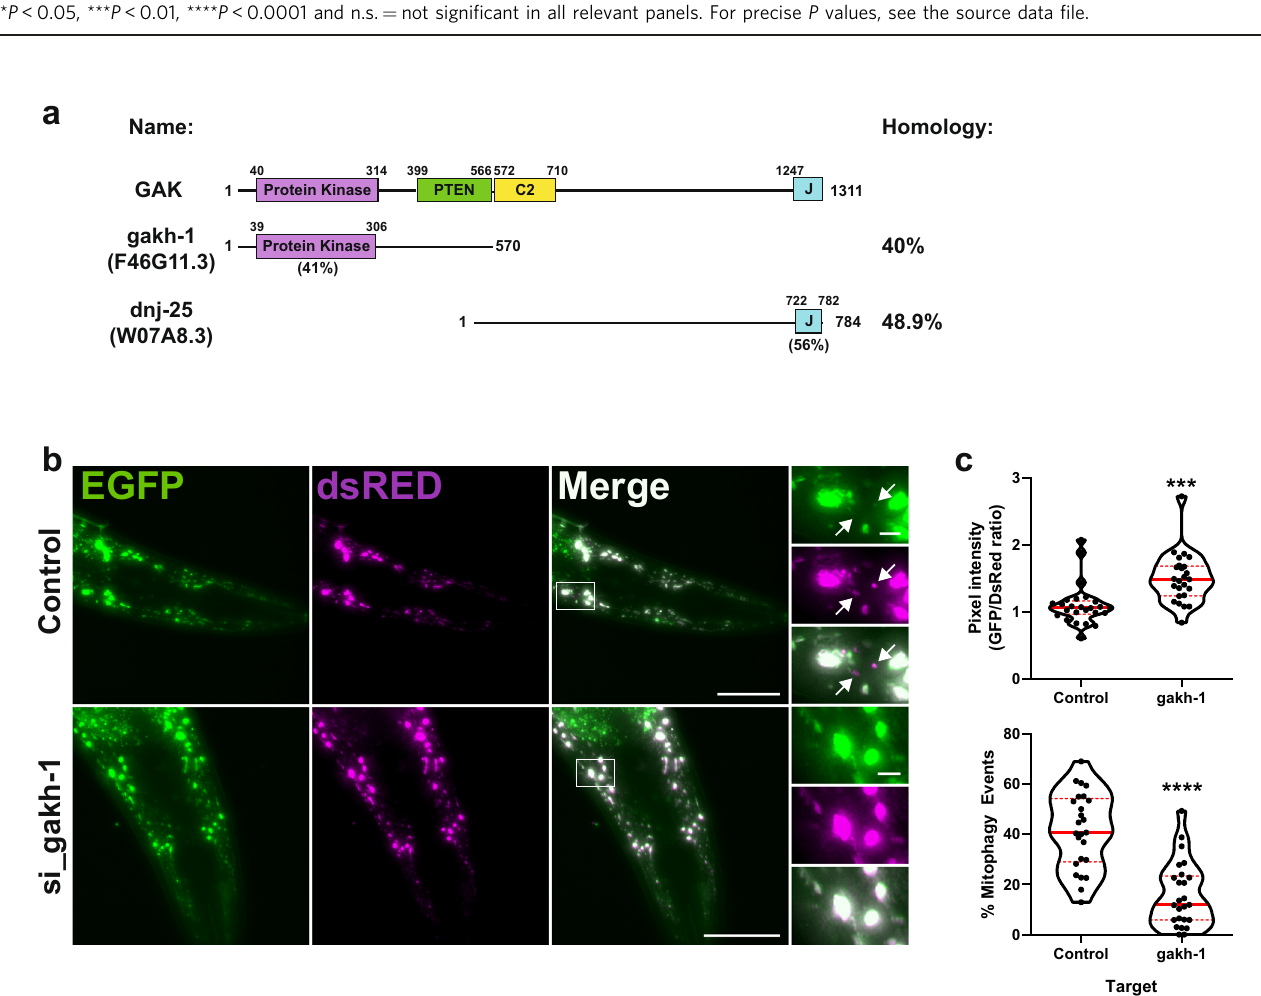
Fig. 7 GAKi induces abnormal mitochondrial and lysosomal morphology. a Representative ×63 images of U2OS IMLS cells taken by Zeiss LSM710 confocal microscopy. Cells were treated ± 1 mM DFP 24 h in addition to GAKi (10 µ M), sotrastaurin (PKCi — 2 µ M), oligomycin and antimycin A (O + A — 10 µ M and 1 µ M, respectively) or CCCP (20 µ M), scale bar = 10 µ m. b Machine-learning classi fi cation of U2OS IMLS cell mitochondrial network as fragmented or tubular (utilising EGFP images, see methods) ± SEM from n = 3 independent experiments after 24 h treatment with GAKi (10 µ M), GAKc (10 µ M) or sotrastaurin (PKCi — 2 µ M) compared to 72 h knockdown of non-targeting control, siDRP1 or siOPA1. Signi fi cance was determined by two-way ANOVA followed by Dunnett ’ s post-test to the control treatment. c U2OS IMLS cells were treated as indicated with DMSO, GAKi or GAKc (10 µ M each) for 24 h in addition to either DFP (24 h, 1 mM), CCCP (20 µ M, 12 h) or in combination. Images obtained by ×20 objective, scale bar = 10 µ m. d Quantitation of mean mitophagy per cell from cells treated as in ( c ) ± SEM from n = 3 independent experiments. Signi fi cance was determined by two-way ANOVA followed by Dunnett ’ s post-test to the equivalent DMSO treatment. e U2OS IMLS cells were treated with 1 mM DFP + 10 µ M GAKi for 24 h prior to fi xation for CLEM analysis. EM images demonstrate mitochondrial clustering (Cell 1) and an increase in autolysosome structures (Cell 2) induced by GAKi treatment, scale bar = 10 µ m, inset = 1 µ M. f U2OS cells treated ± 1 mM DFP 24 h in addition to DMSO, GAKi (10 µ M) or GAKc (10 µ M) were PFA fi xed and subsequently stained for endogenous LAMP1. Images acquired at ×20 by wide fi eld microscopy on a Zeiss AxioObserver microscope, scale bar = 10 µ m. g Quantitation of LAMP1 structures identi fi ed in ( f ) for size and number and plotted as mean ± SEM from n = 4 independent experiments. Signi fi cance was determined by two-way ANOVA followed by Dunnett ’ s multiple comparisons test to the DMSO control. Signi fi cance was denoted where